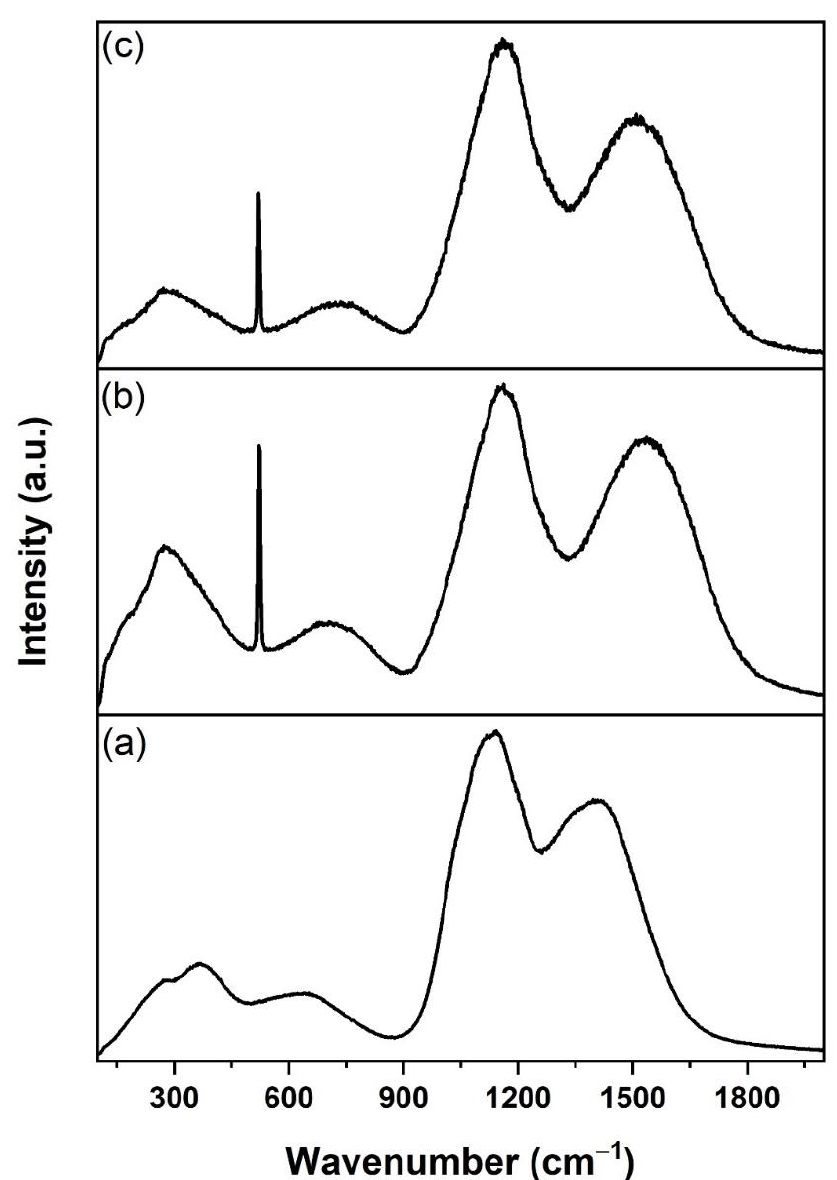
Figure 6. Raman spectra of samples ( a ) B400, ( b ) B570, and ( c ) B700. B570 and B700 samples show similar spectra.